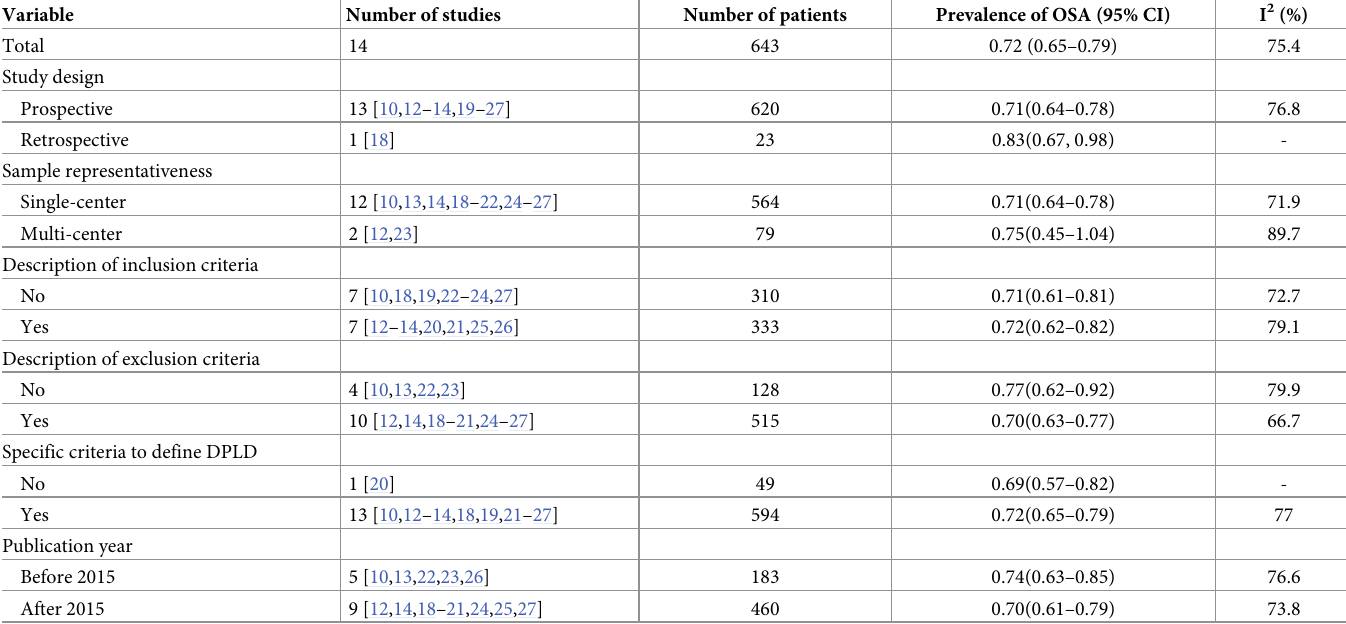
Table 2. Meta-analysis of the overall prevalence of OSA in